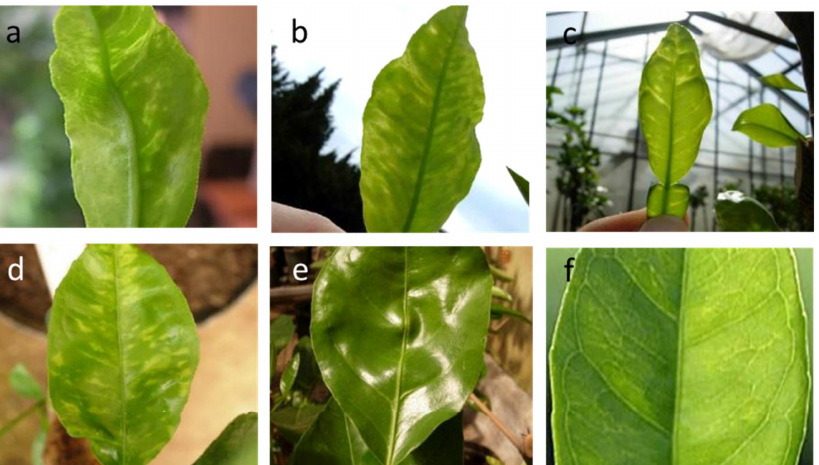
Figure 7. Citrus yellow vein clearing virus induces vein clearing, yellow flecks, and distortion of young leaves of lemon ( a , b ) and sour orange ( c , d ), which may be persistent on mature leaves ( e ) and very mild on some sweet orange varieties ( f